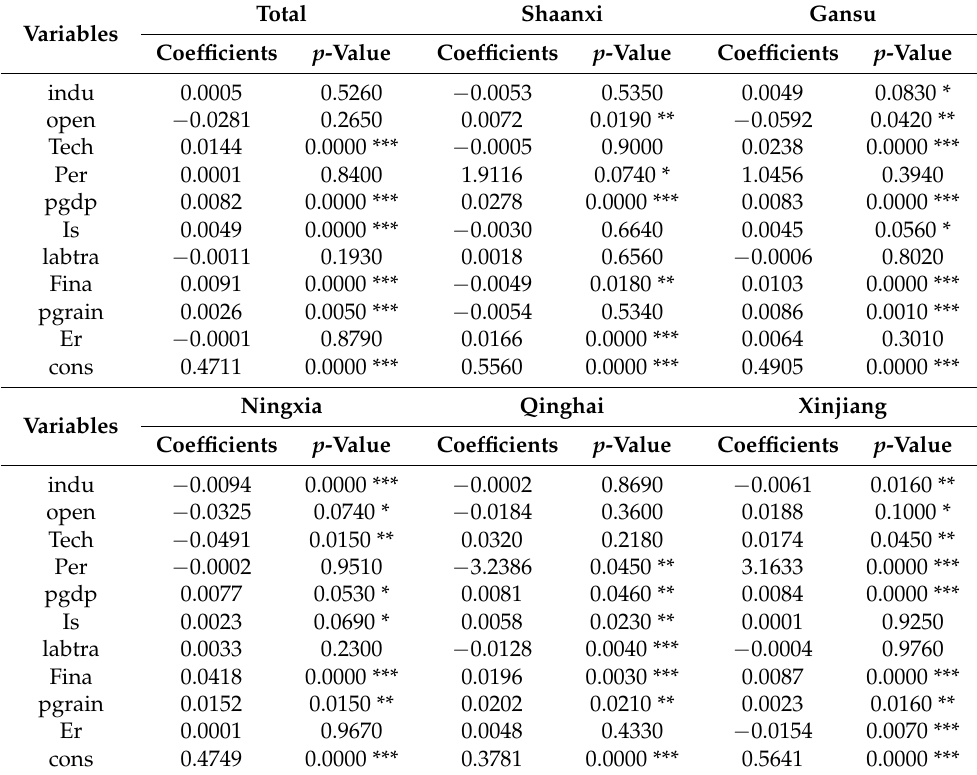
Table 5. Regression